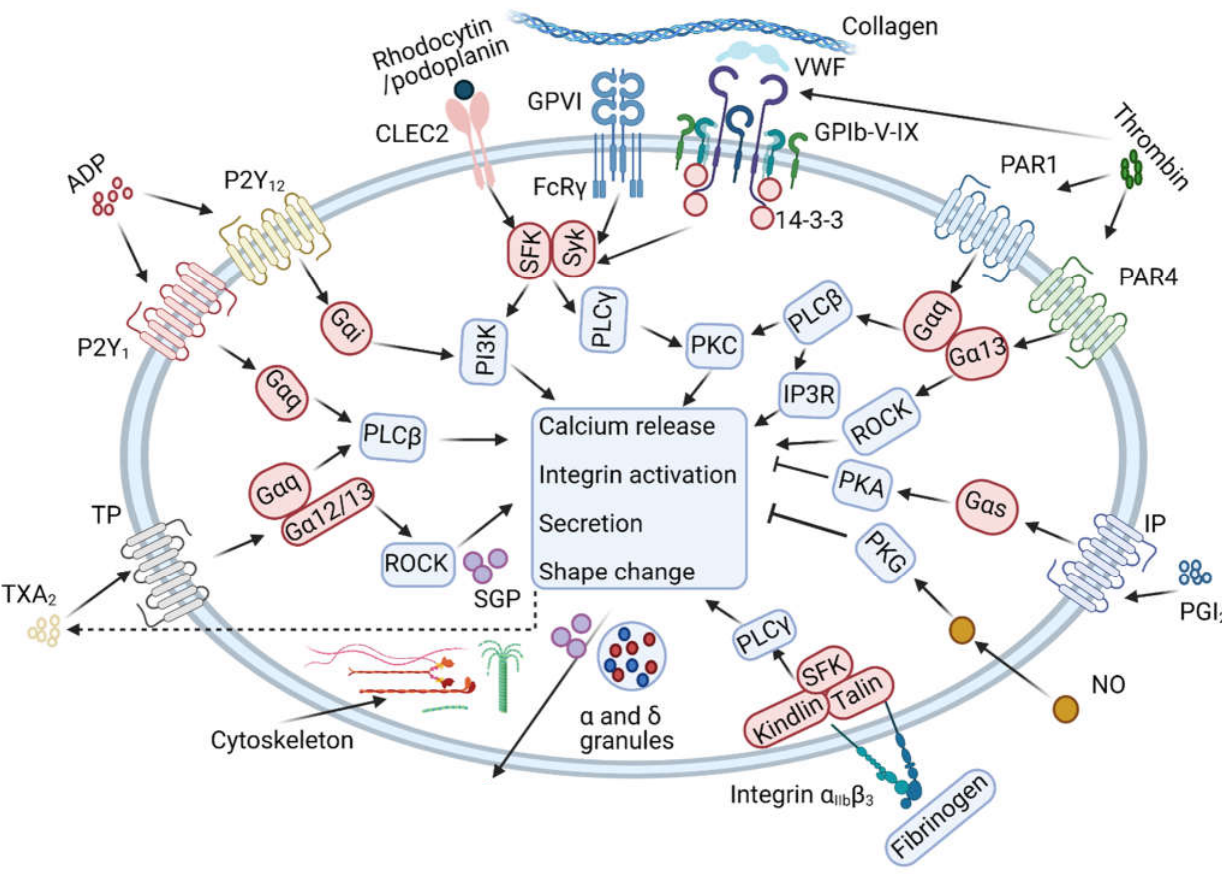
Figure 2. General overview of platelet signalling pathways. Overview of key platelet signalling and responses via key platelet receptors and agonists, examined by platelet proteomic analysis. Indicated are signalling via the collagen receptor glycoprotein (GP)VI, VWF receptor GPIb-V-IX; the proteinase-activated receptor (PAR)1 and PAR4 for thrombin; the podoplanin and rhodocytin receptor C-type lectin receptor 2 (CLEC2); the ADP receptors P2Y 1 and P2Y 12 ; thromboxane (TX)A 2 mimetic U46619 (pathway inhibited by aspirin); integrin α IIb β 3 outside/in signalling; actin and tubulin cytoskeletons; platelet-inhibiting prostacyclin I 2 (PGI 2 ) and nitric oxide (NO); and α-granule and δ-granule secretion. Other abbreviations: Gα, heterotrimeric G proteins; PKA, PKC, PKG, protein kinases A, C, G; PLC, phospholipase C; SGP, small GTP-binding proteins; SFK, Src-family kinase. Refs. [2,5,21]. Originally created with BioRender.com accessed on 10 July 2021.